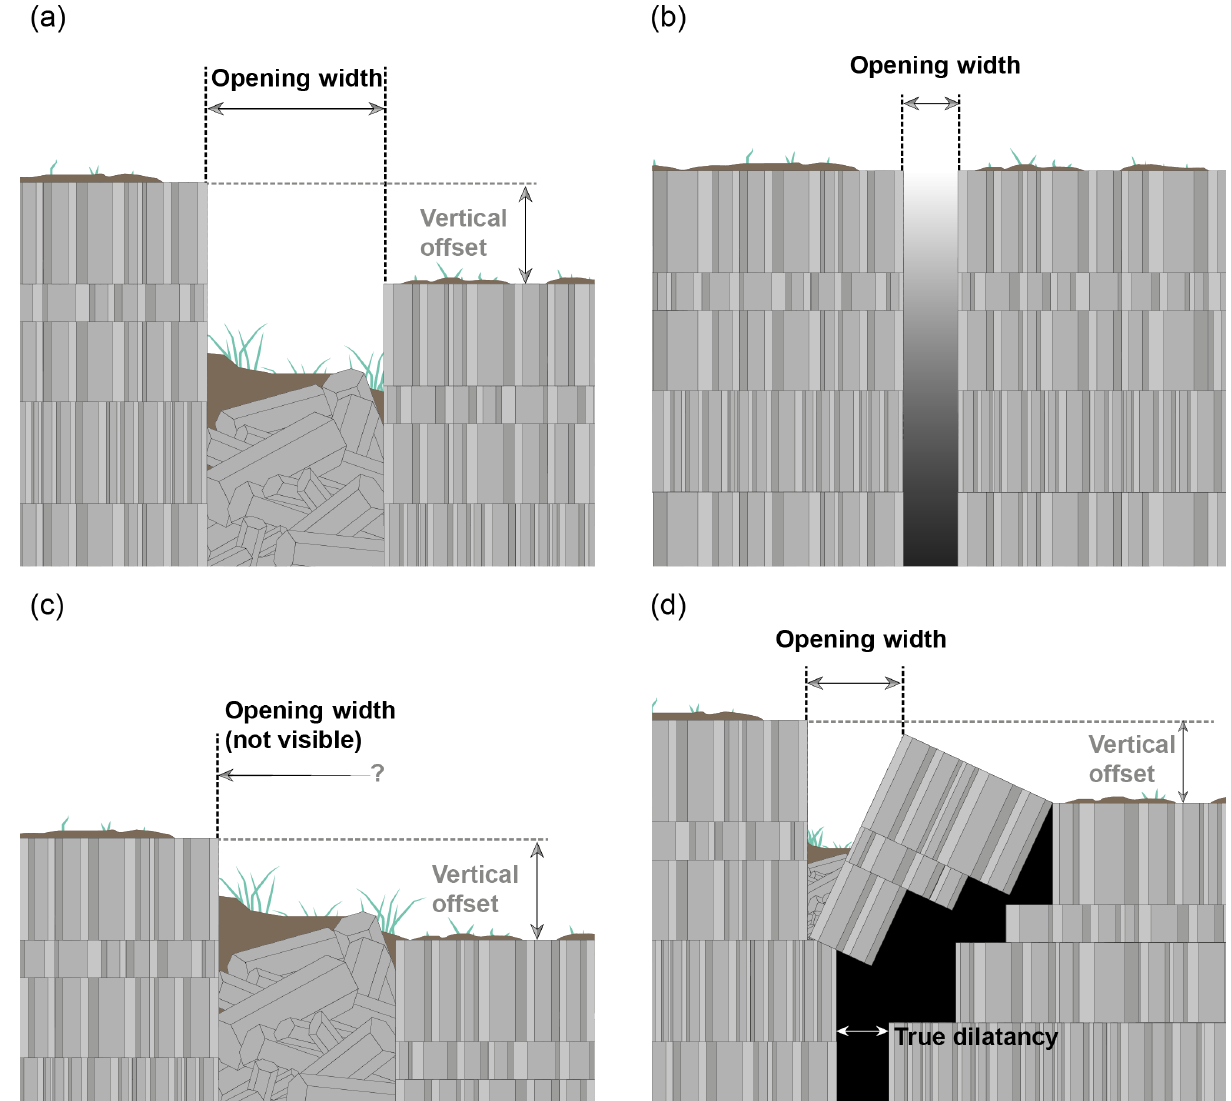
Figure 12. (a) Dilatant fault. The opening is filled by detached columns, rubble and sediment. The opening width is measured from edge to edge, vertical offset from the top of the footwall to the top of the hanging wall with a distance to the opening. (b) Fissure: the opening is measured from edge to edge and can remain open (unfilled) to uncertain depth. (c) Dilatant fault with the opening filled to the surface, thus preventing accurate measurements. Vertical offset is measured from the top of the footwall to the top of the hanging wall. (d) Tilted block (Type I of Kettermann et al., 2019). The opening width is measured from edge to edge and can be filled with detached columns, rubble or sediment. The opening on the surface is larger than the true dilatancy at depth. Vertical offset is measured from the top of the footwall to the top of the hanging wall with a distance to the TB. Not to